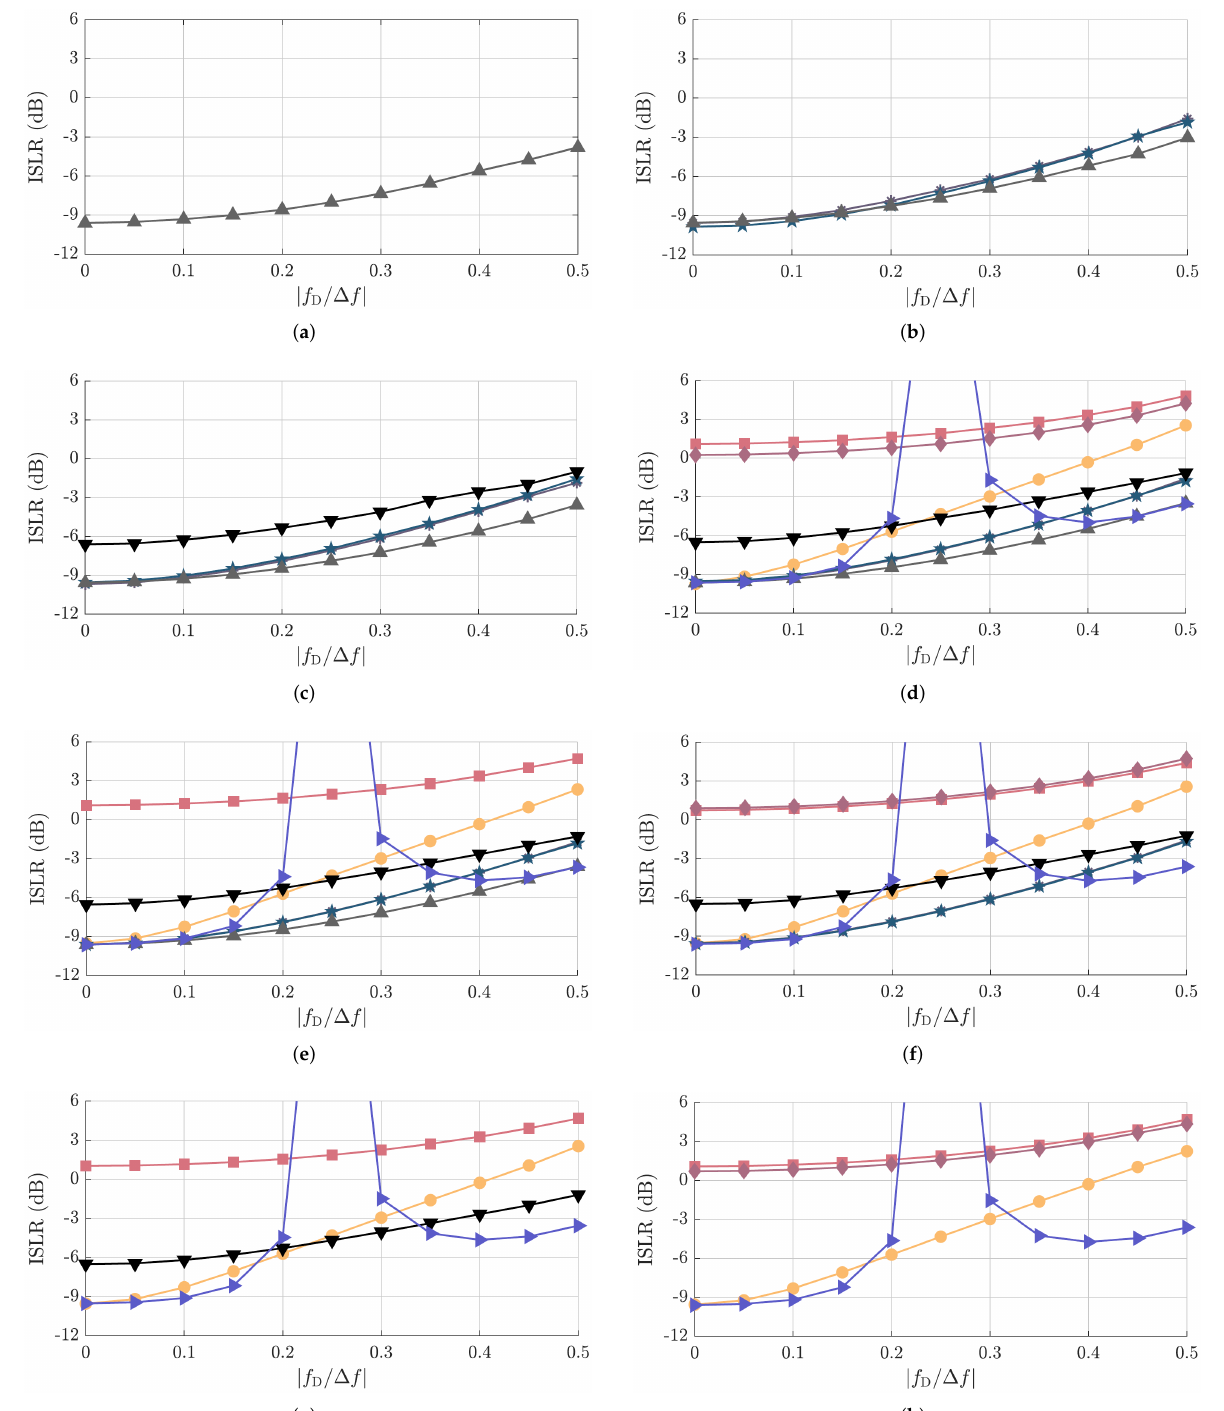
Figure 12. Measured ISLR as a function of f D / ∆ f for the considered PRBSs with approximate PACF usable length of ( a ) N PRBS,usable = 32, ( b ) N PRBS,usable = 64, ( c ) N PRBS,usable = 128, ( d ) N PRBS,usable = 256, ( e ) N PRBS,usable = 512, ( f ) N PRBS,usable = 1024, ( g ) N PRBS,usable = 2048, and ( h ) N PRBS,usable = 4096. The considered PRBSs are m-sequence